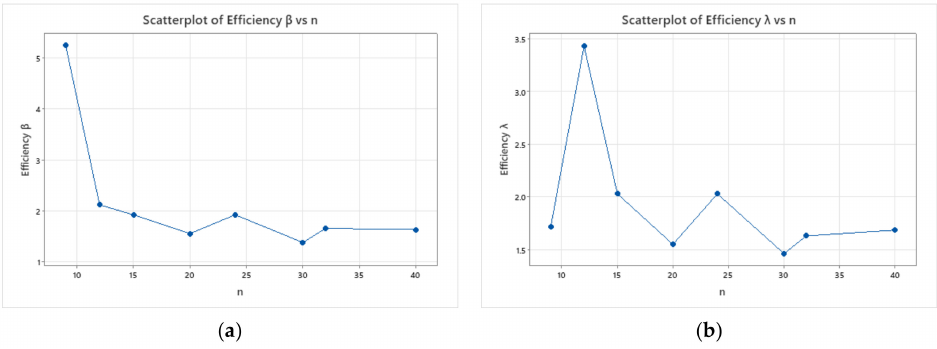
Figure 3. The efficiency of the MLE parameters β ( a ) and λ ( b ) when β = 1.5 and λ =